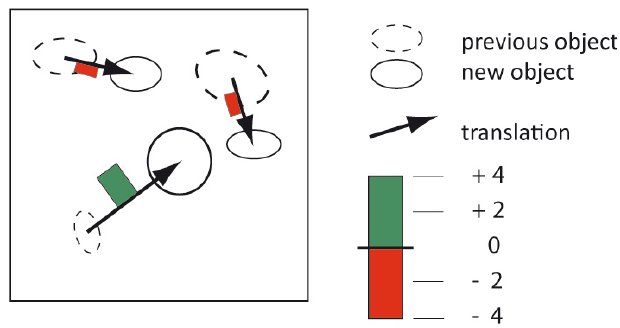
Figure 2. Combined symbol for object translation and change in absolute value.